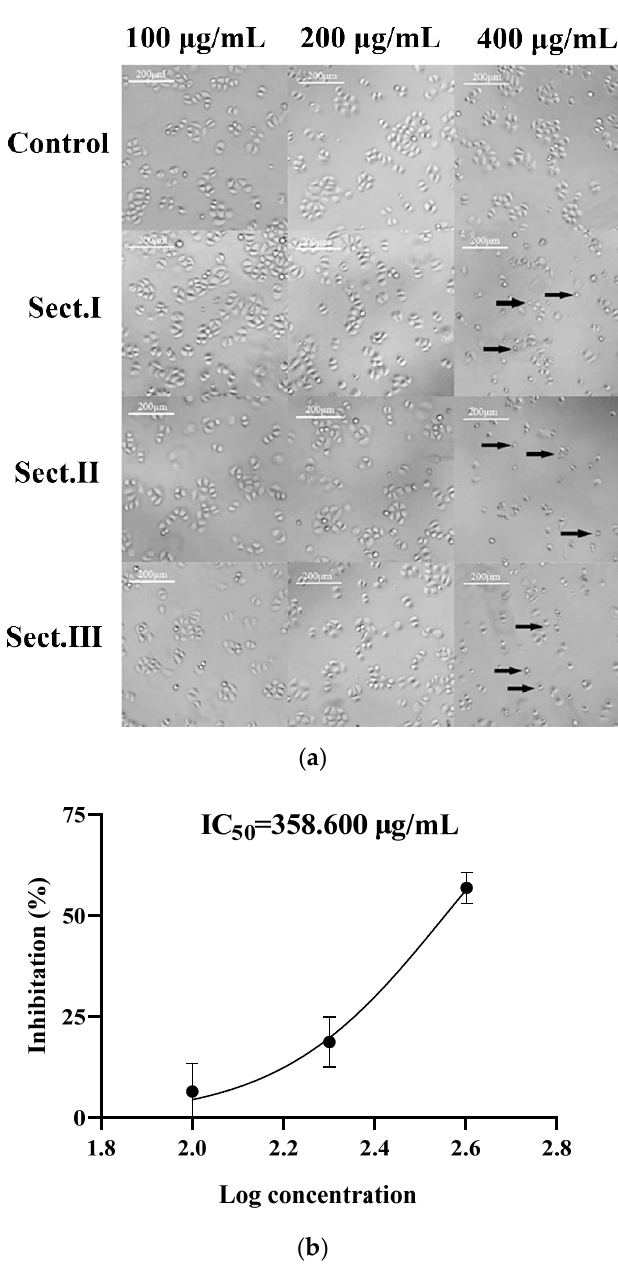
Figure 1. ( a ) Effects of ultra-filtration components in hemolymph of A. chinensis on SGC-7901 cells after 48 h treatment. Control: cell group without drug; Sect. I: molecular weights of the section < 3 kD; Sect. II: molecular weights of the section between 3 kD and 50 kD; Sect. III: molecular weights of the section > 50 Kd, the cells indicated by the arrow are morphologically altered cells. ( b ) IC 50 curve fitting of Sect. II. Table 1. Inhibitory rates of cell proliferation (SGC-7901 cells) induced by various components of A. chinensis hemolymph separated by ultrafiltration after 48 h treatment.